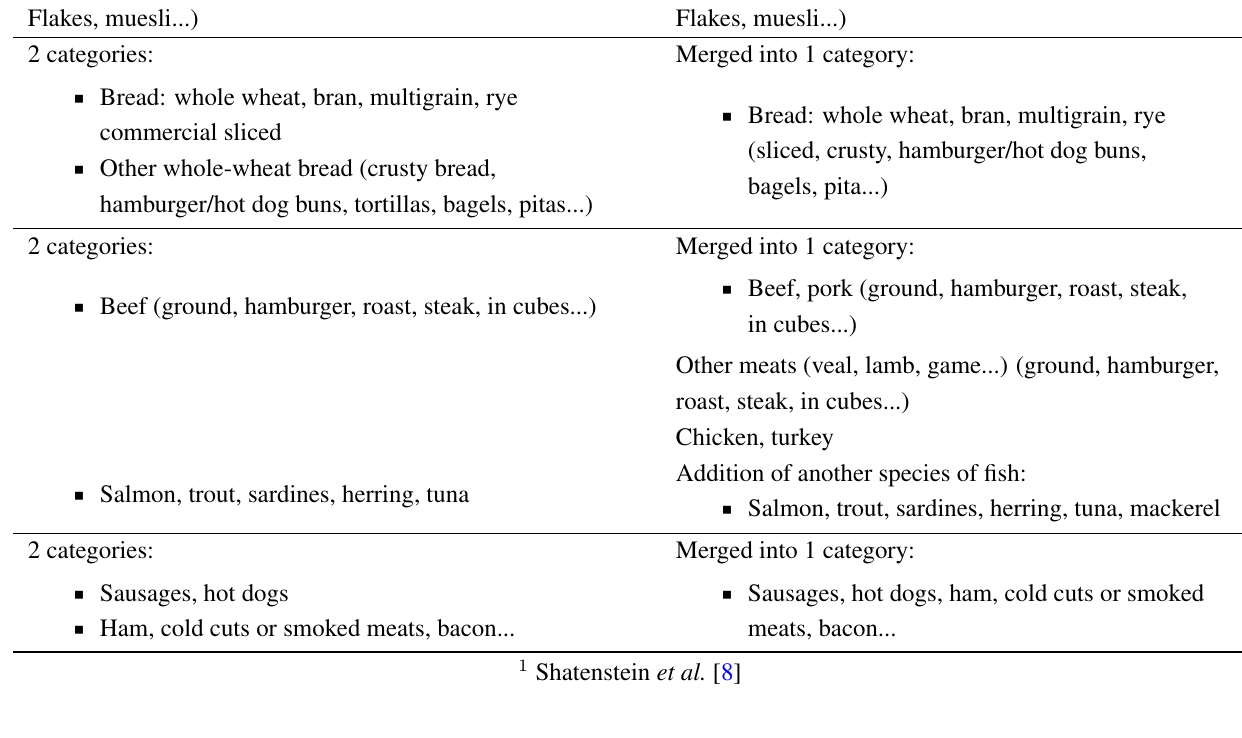
Table A1. Sample food list modifications from the full FFQ to the SDQ. Full FFQ 1 SDQ High-fibre breakfast cereals (All Bran, 100% Bran, Bran High-fibre breakfast cereals (All Bran, 100% Bran, Bran Flakes, muesli...) Flakes, muesli...)